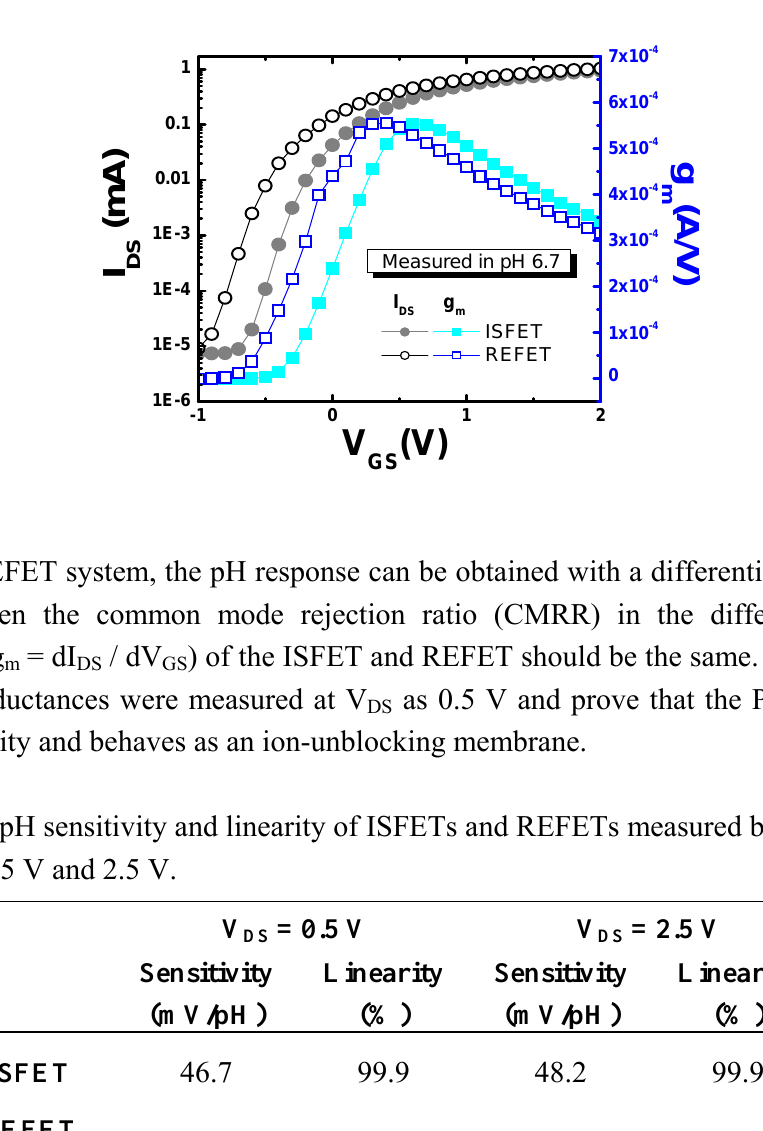
-V curves and transconductance (g Figure 6. The I DS GS = 0.5V. at V DS